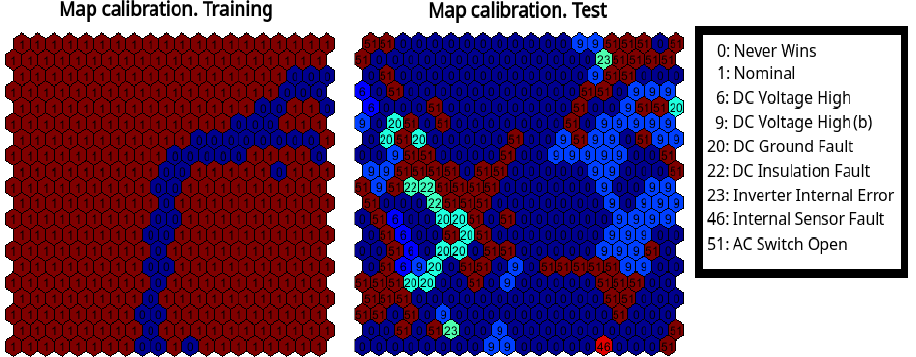
Figure 2. Calibration of the trained SOM, using training data and test data.